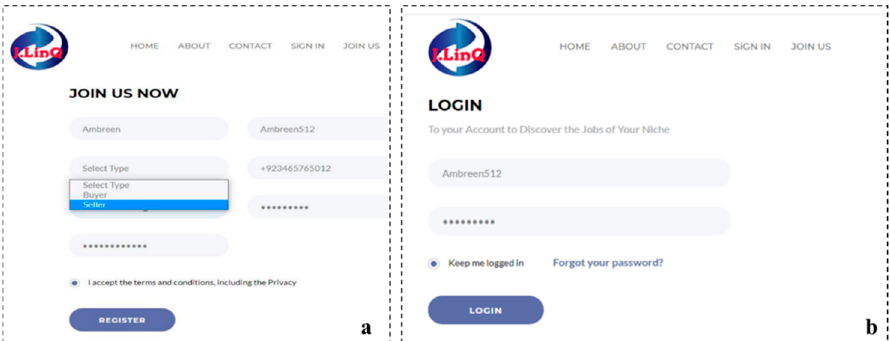
Figure 10. ( a ) User registration and ( b ) login interface of the